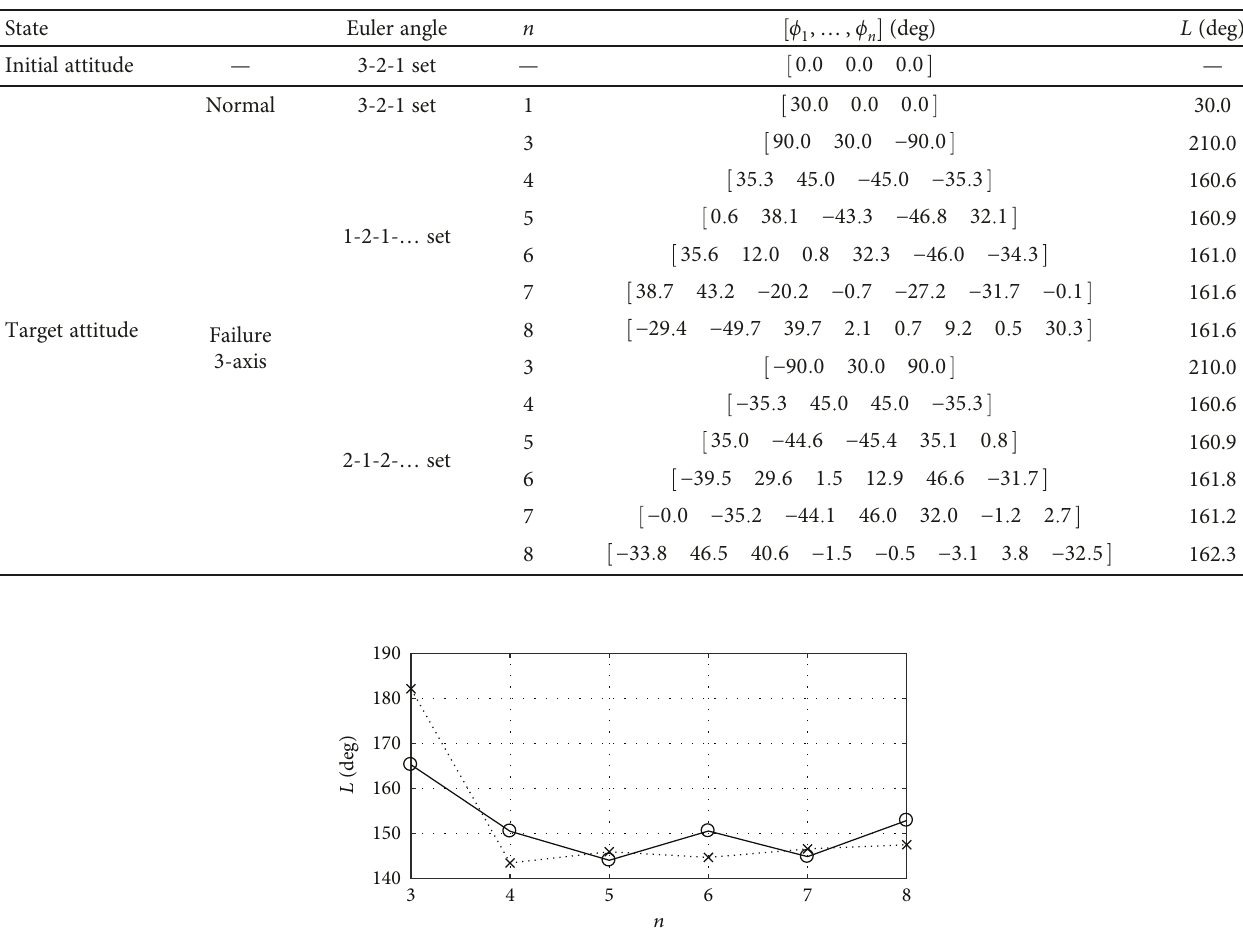
Table 2: Initial and obtained sets of a target attitude for case